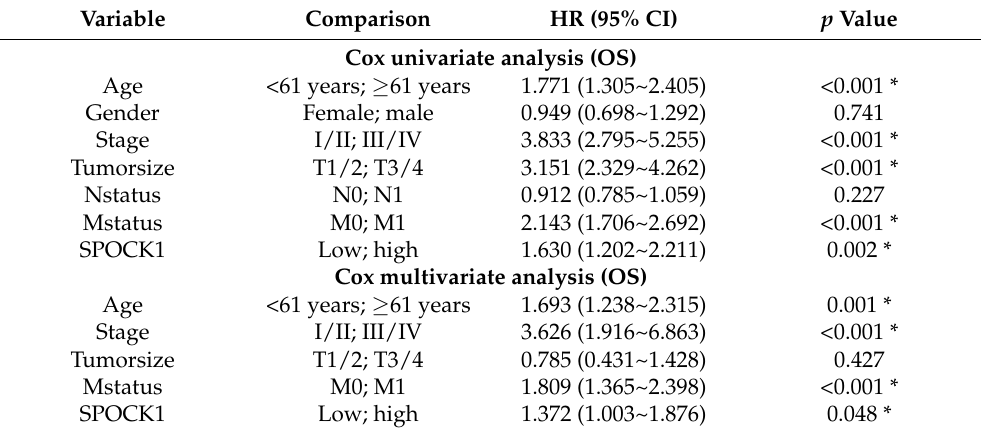
Table 1. Cox univariate and multivariate regression analyses of prognostic factors and SPOCK1 expression for overall survival (OS) in 533 clear cell renal cell carcinoma (ccRCC) patients.